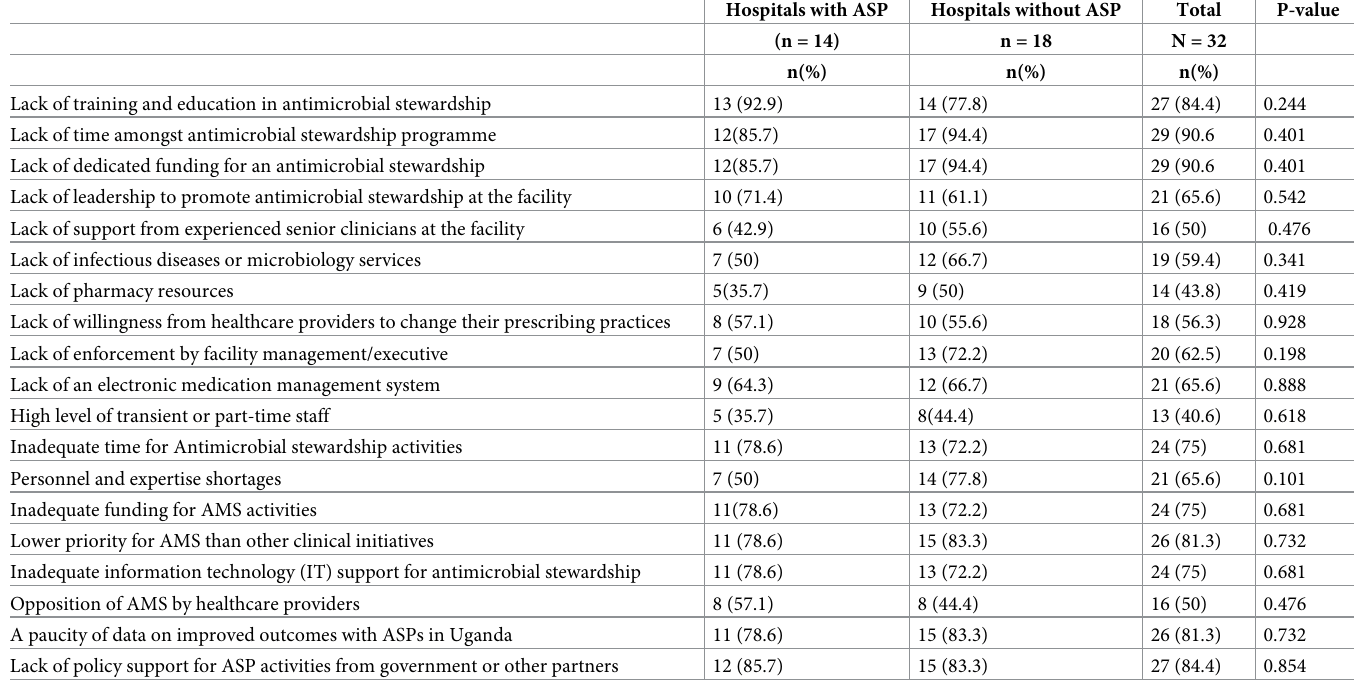
Table 4. Challenges of implementing ASP in hospitals with or without an ASP (N =